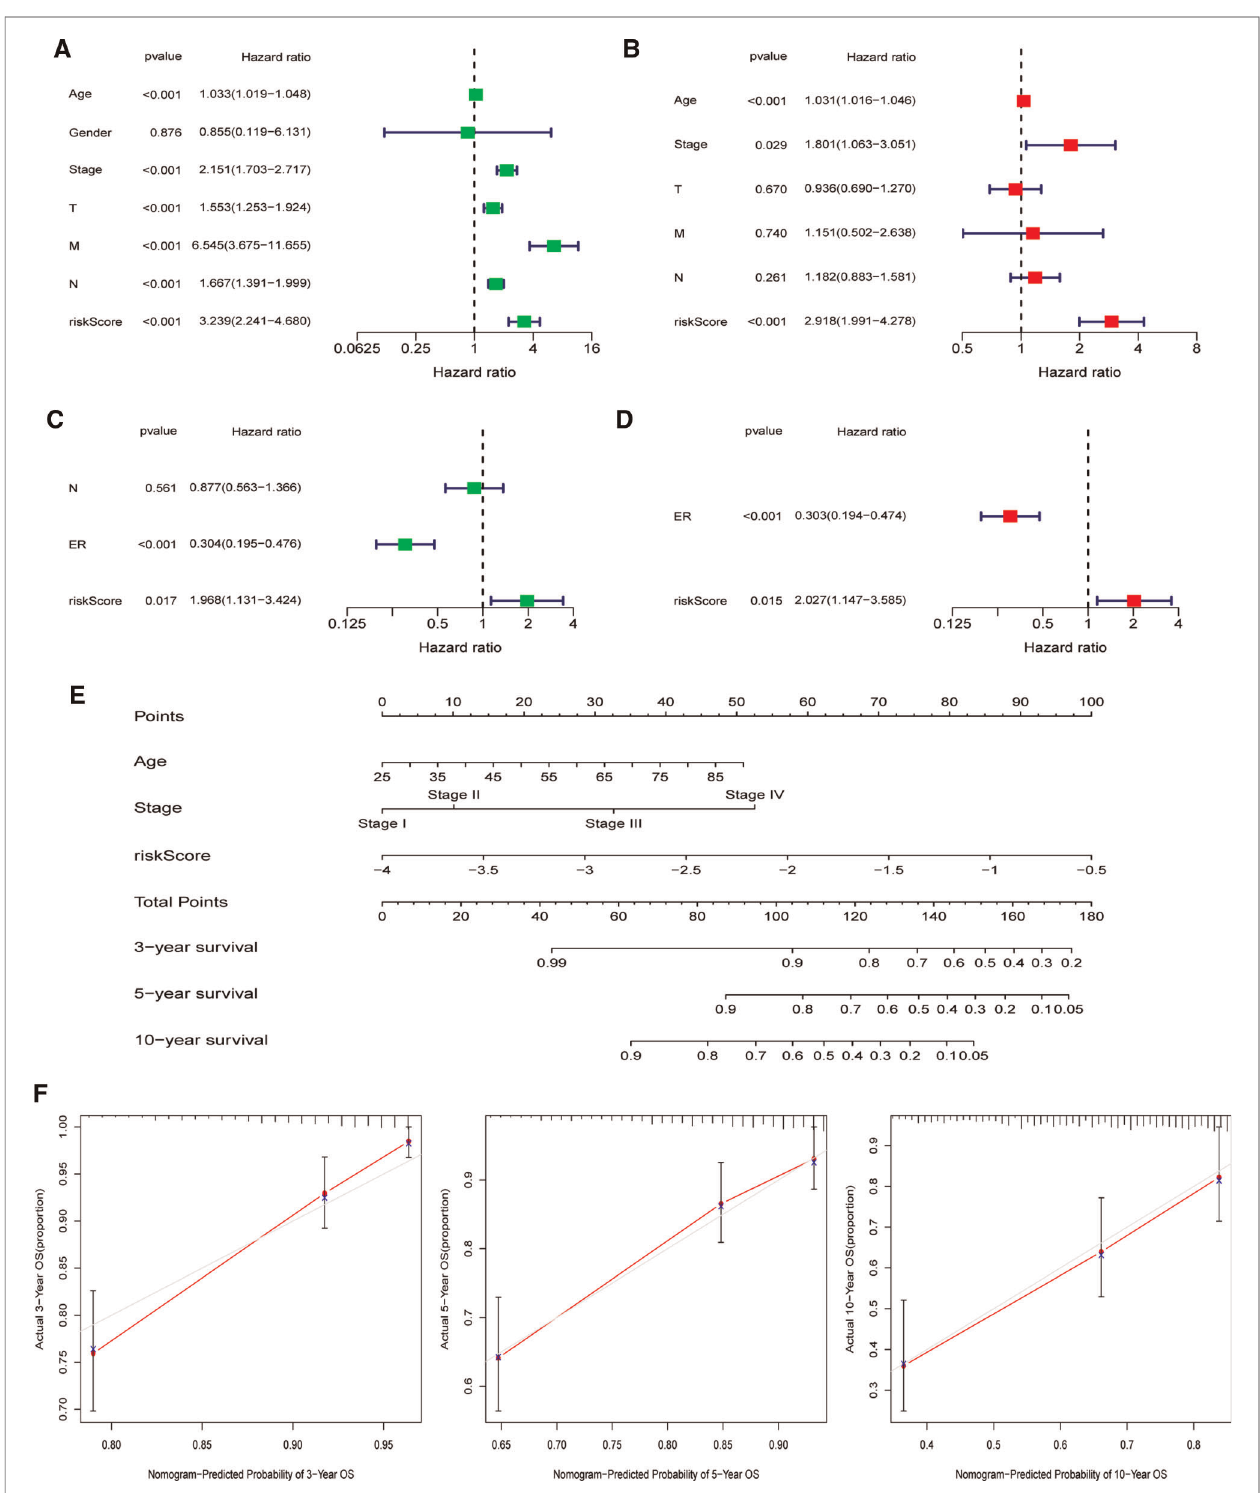
FIGURE 9 | Establishment of the nomogram in the TCGA-BRCA cohort. ( A ) Univariate and ( B ) multivariate COX regression regarding OS in TCGA-BRCA cohort. ( C ) Univariate and ( D ) multivariate COX regression regarding OS in GEO validation cohort. ( E ) Nomogram for 3-, 5-, and 10-year survival prediction in the TCGA-BRCA cohort. ( F ) Calibration curves for assessing the predictive accuracy of the 3-, 5-, and 10-year OS.